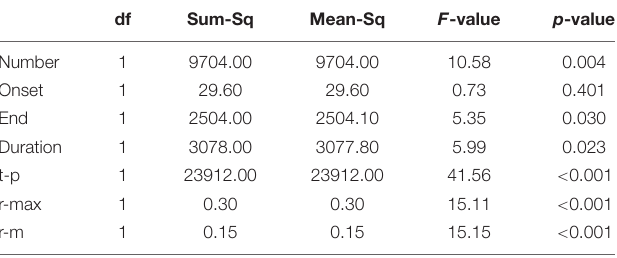
condition, the cambial cells would be in dormancy, and could resume the cell division when the moisture levels are suitable (Camarero et al., 2010).